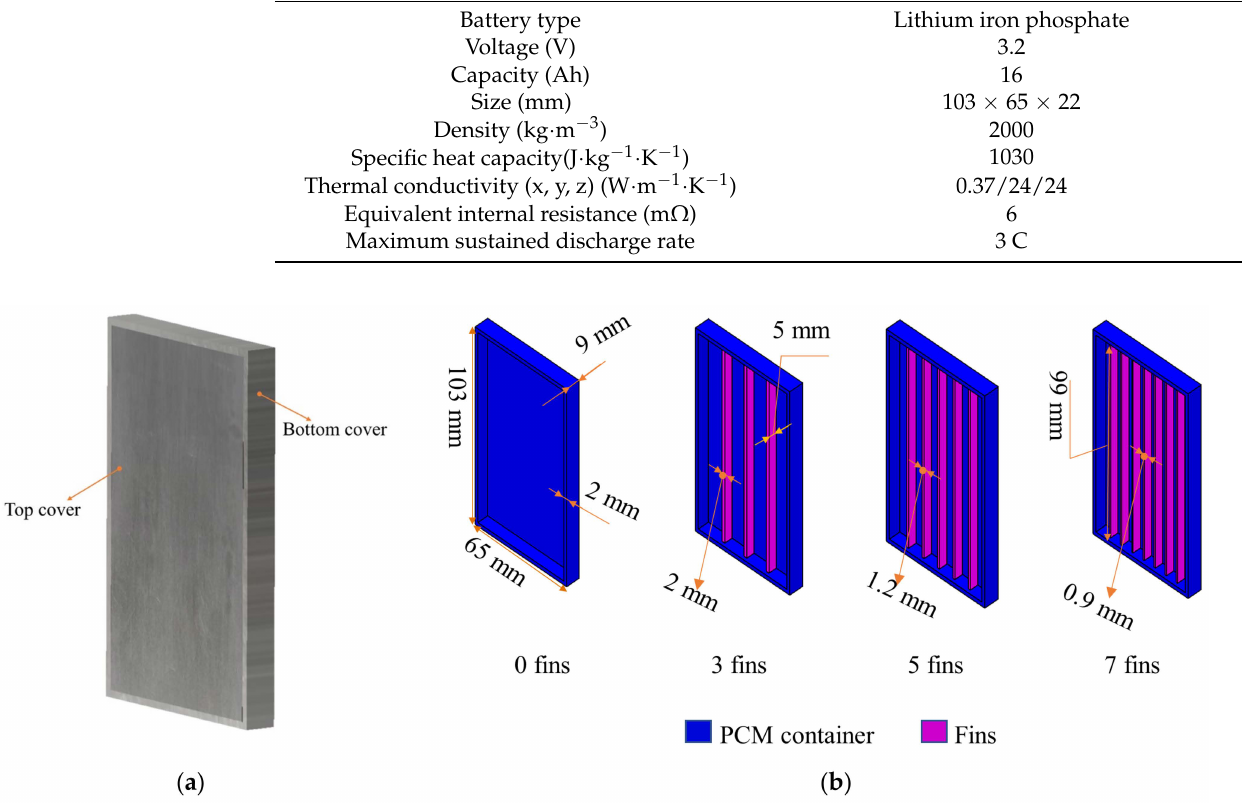
Figure 2. PCM container: ( a ) PCM container assembly; ( b ) PCM container inner